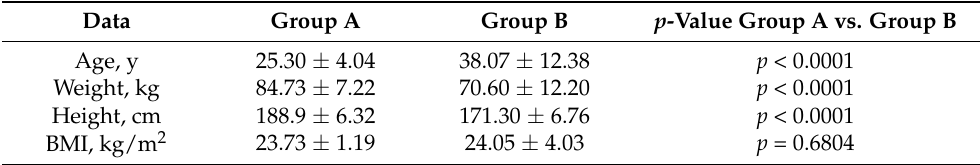
Table 1. Descriptive data of the sample.